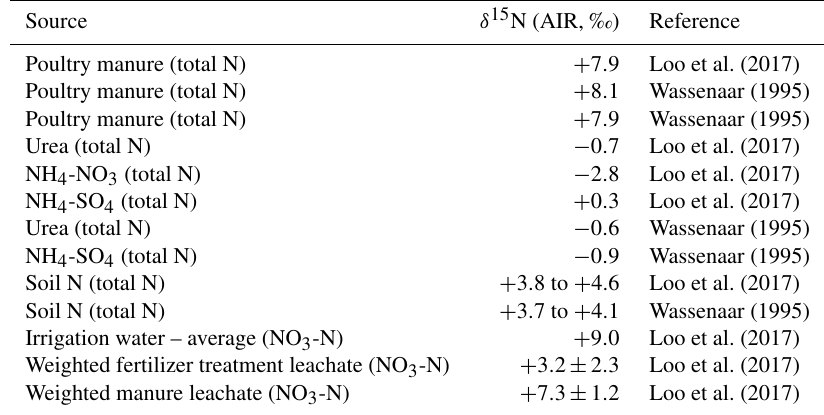
Figure 1. Location of the Abbotsford–Sumas aquifer (ASA), southwestern BC, Canada, and northwestern Washington state, USA, along with simplified agricultural land use and sampling locations with groundwater mean residence times (MRT) of <5 years. Arrows show the approximate groundwater flow direction. Table 1. Local synthetic fertilizer, poultry manure, soil N, and leachate δ 15 N values used in the Abbotsford